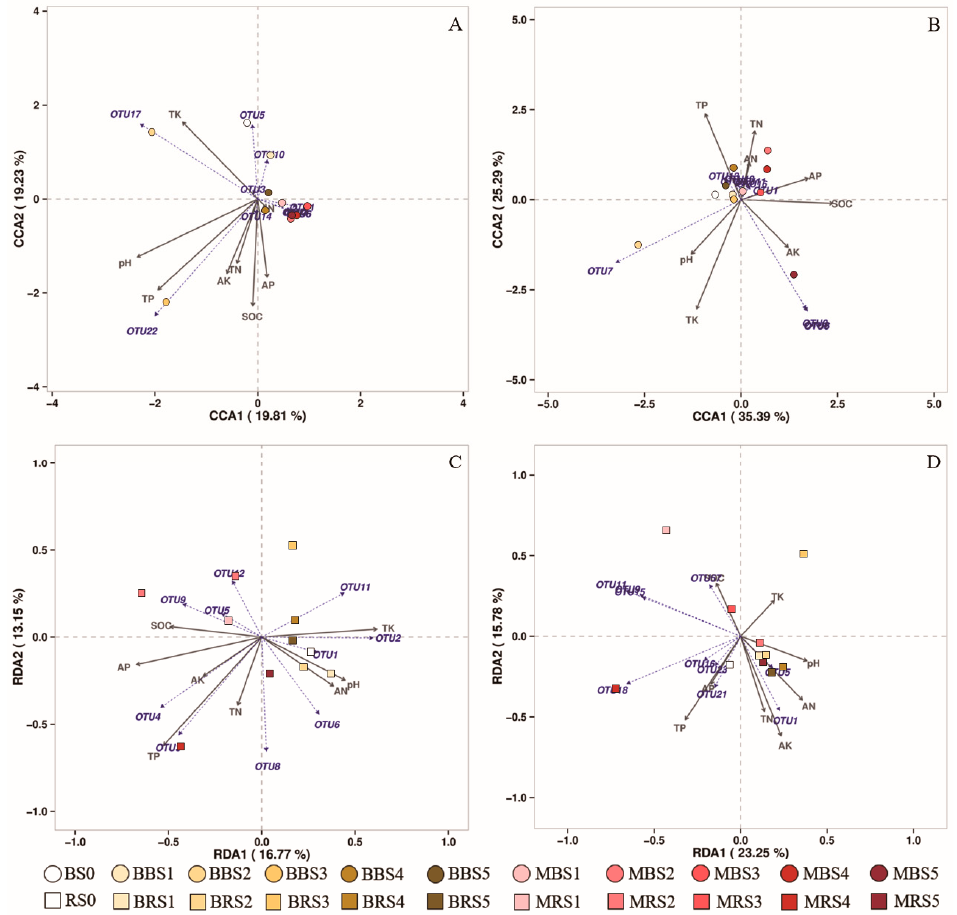
Figure 9. Redundancy analysis (RDA) / canonical correlation analysis (CCA) of the soil fungal and bacterial communities at the OTU level. ( A ) Fungal community in bulk soil. ( B ) Bacterial community in bulk soil. ( C ) Fungal community in rhizosphere soil. ( D ) Bacterial community in rhizosphere soil. B and M indicate bamboo biochar and bacteria-inoculated biochar; BS and RS indicate bulk soil and rhizosphere soil. 0, 1, 2, 3, 4, and 5 indicate control, 2.22 t·ha − 1 , 4.44 t·ha − 1 , 6.67 t·ha − 1 , 8.89 t·ha − 1 , and 11.11 t·ha − 1 .